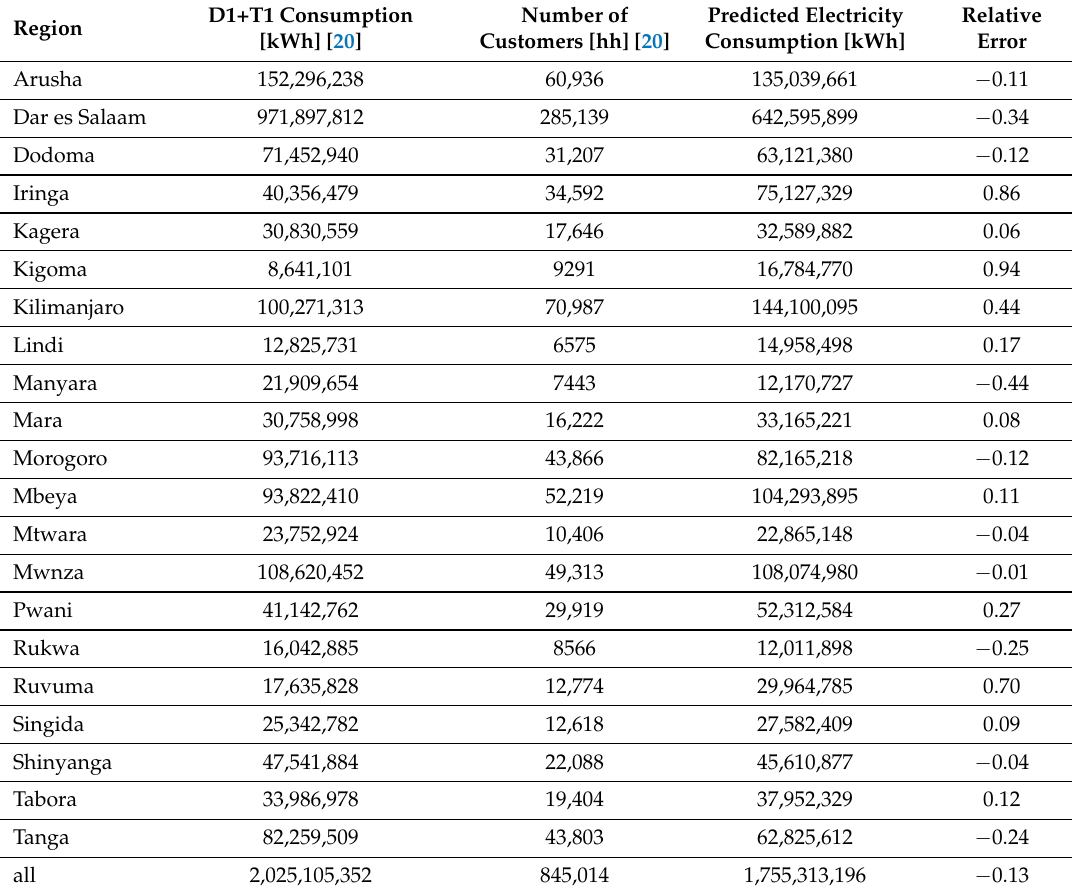
Table 4. Actual electricity data in 2010 from [20], number of subscribers, electricity consumption predicted by model, and the